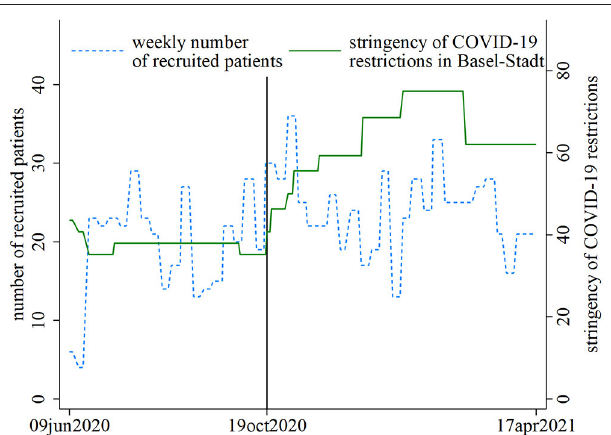
FIGURE 1 | SomPsyNet recruitment (blue/dashed line) and stringency of coronavirus disease 2019 (COVID-19) restrictions in the canton of Basel-Stadt, Switzerland (green/solid line), in the study period. The black line separates the periods with modest (pre-period) vs. strong (post-period) COVID-19